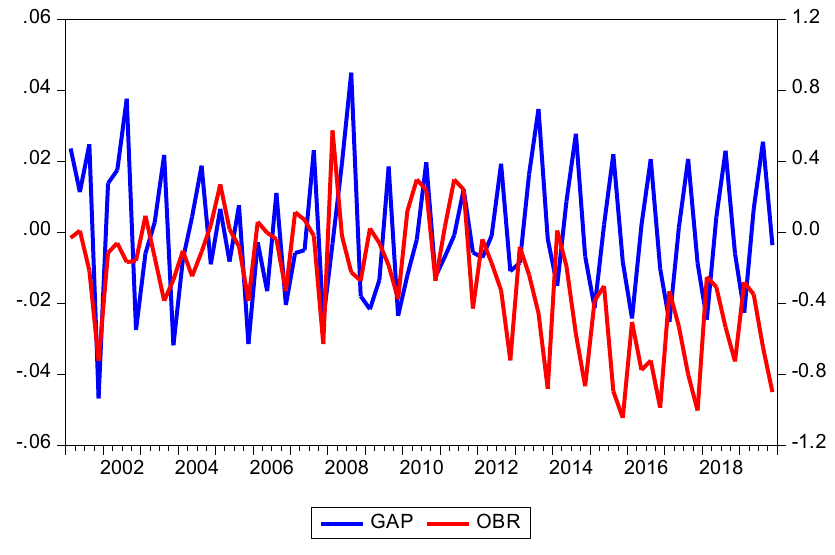
Figure 1. Output Gap and Overall Balance